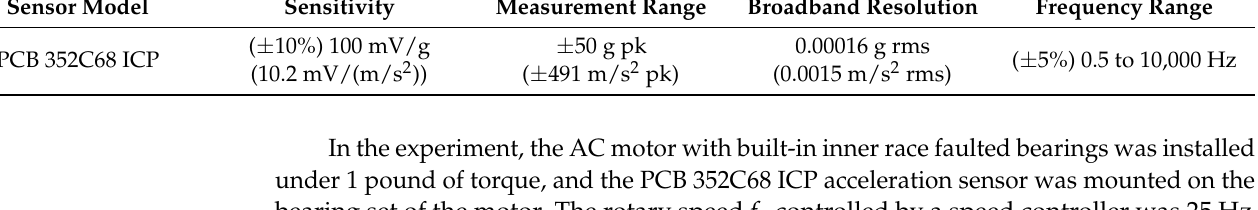
Figure 26. ( a ) Structure of the machinery fault simulator. ( b ) AC motor with acceleration sensor mounted. Table 1. Technical details of the acceleration